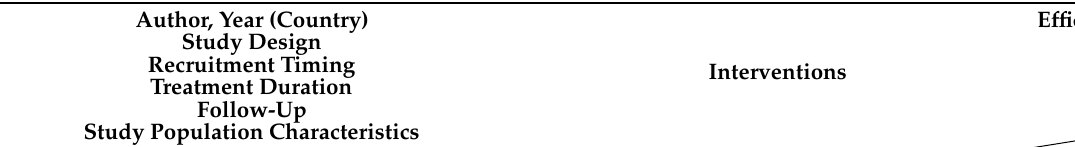
Table 1. Detailed description of the studies